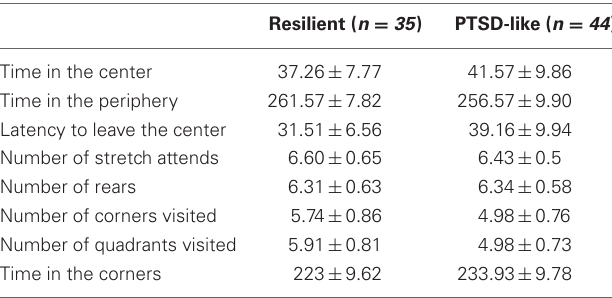
Table 1 | Comparison between the behavior of resilient and PTSD-like rats in the open